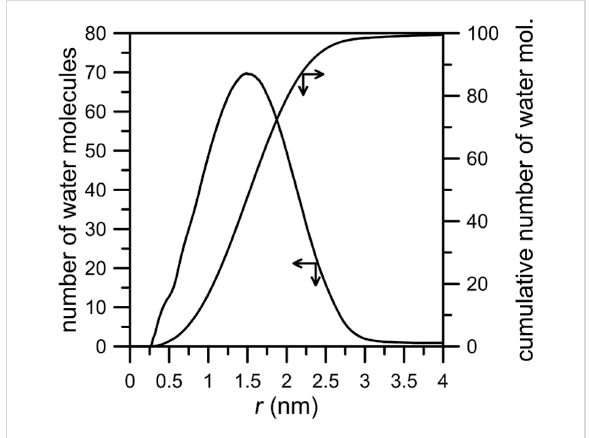
Figure 6: The number of water molecules plotted as a function of the distance of O w atoms from the center of the rim of an NHH nanopore (here it is the geometric center of carbon and nitrogen atoms in the nanopore rim) calculated for a CH 4 + N 2 gaseous mixture containing 200 water molecules. Other notes are the same as in Figure 4.